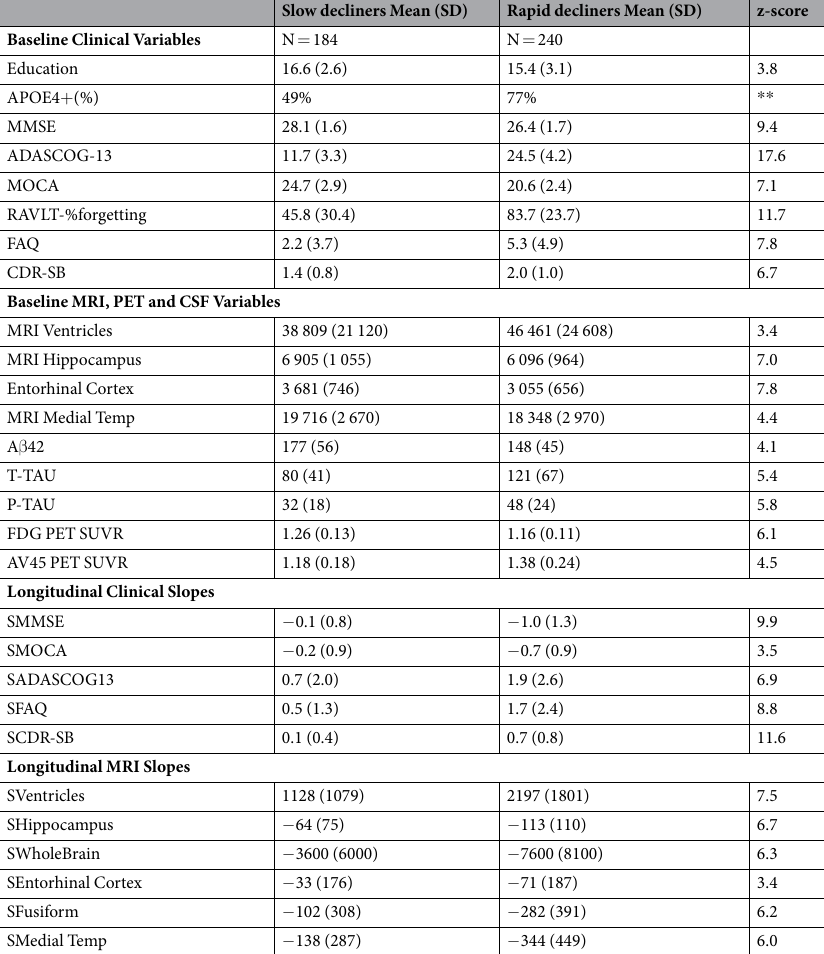
Table 3. Clinical and Biomarker Differences between slow and rapid decliners All variables in the table were statistically significant at least p < 0.01 or greater using Mann Whitney test. ApoE4 prevalence was tested using the chi-square test and was also significant between groups. The prefix “S” depicts longitudinal change slope. See statistical methods for details.